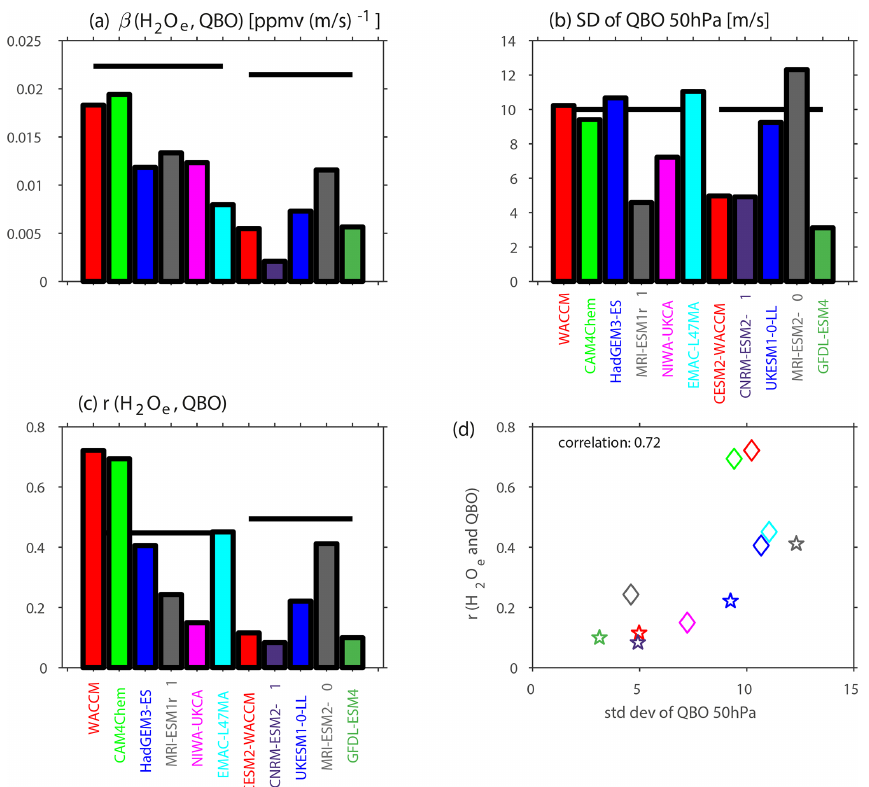
Figure 8. Relationship between the QBO and entry water vapor in CCMI and CMIP6 models. (a) Regression coefficient, (b) standard deviation of the QBO at 50hPa, (c) correlation coefficient and (d) relationship between the correlation coefficient (panel c ) and standard deviation (panel b ), with the color of markers corresponding to the color used in panel (b) and (c) . For (d) , diamonds are CCMI models, and stars are CMIP6 models. A solid black line in panels (a) – (c) is for reanalysis. Note that entry water is defined near 80hPa for CCMI models and at 70hPa for CMIP6 models; hence the solid black reanalysis line differs for each. Note that the WACCM, CAM4Chem and EMAC-L47MA models included in CCMI (the first, second and sixth models in panels a , b and c ; green, red and cyan) nudge the QBO; in all other models the QBO is spontaneously